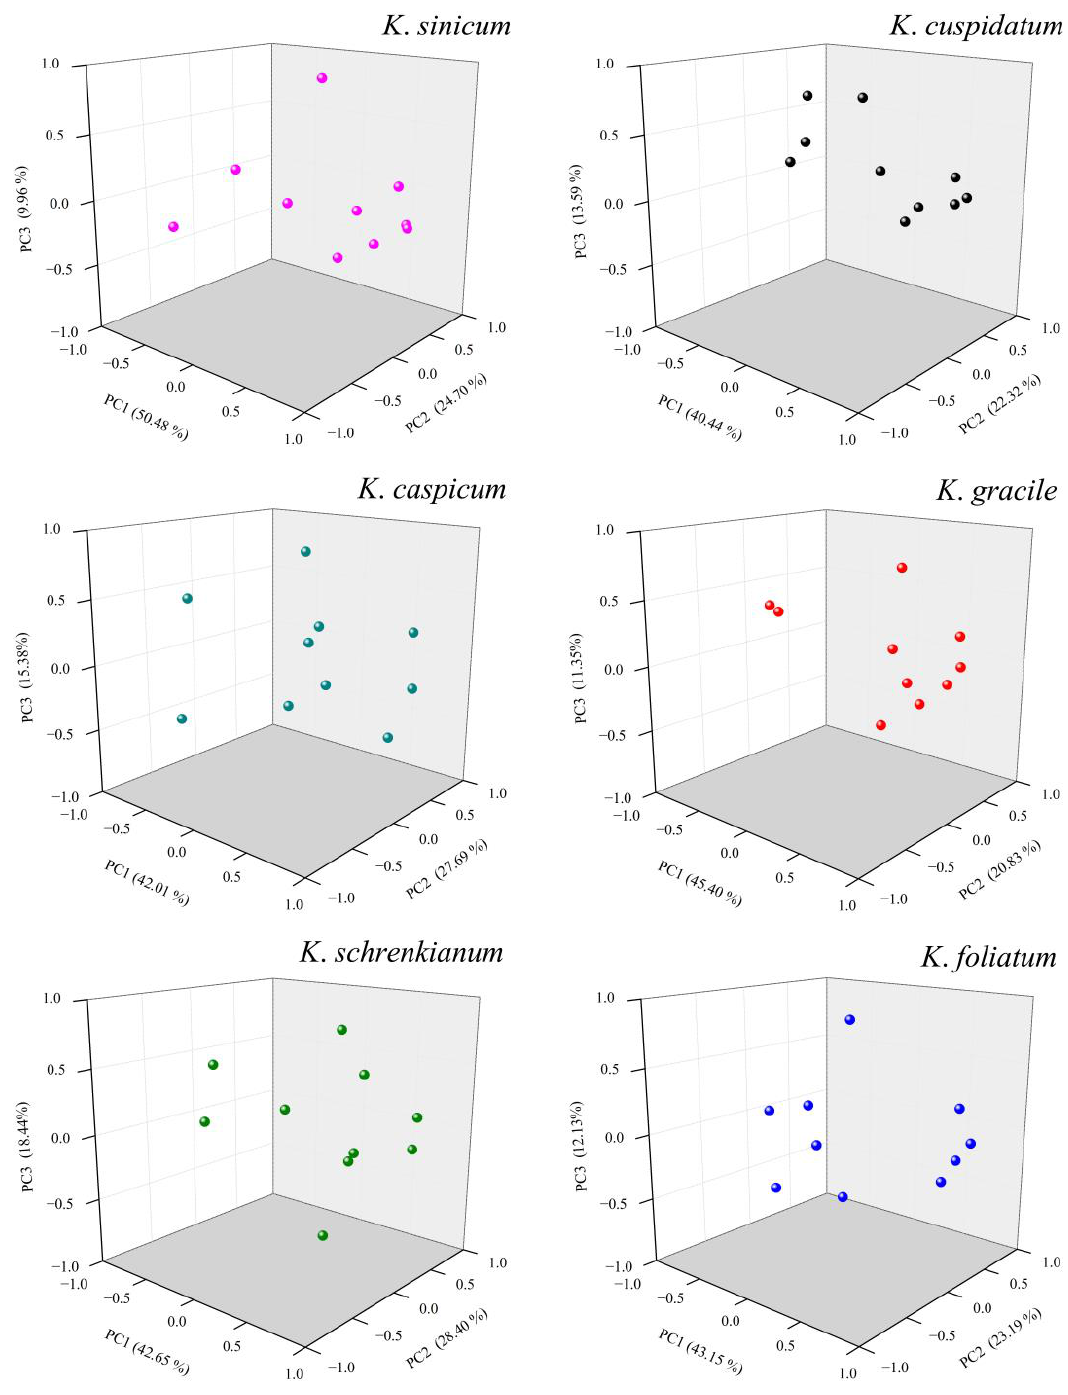
Figure 8. Score plots obtained from Principal Component Analysis (PCA) of effects of abiotic factors on distributions of the six Kalidium species. x axis, y axis, and z axis indicate the first, the second and the third Principle Component, respectively.